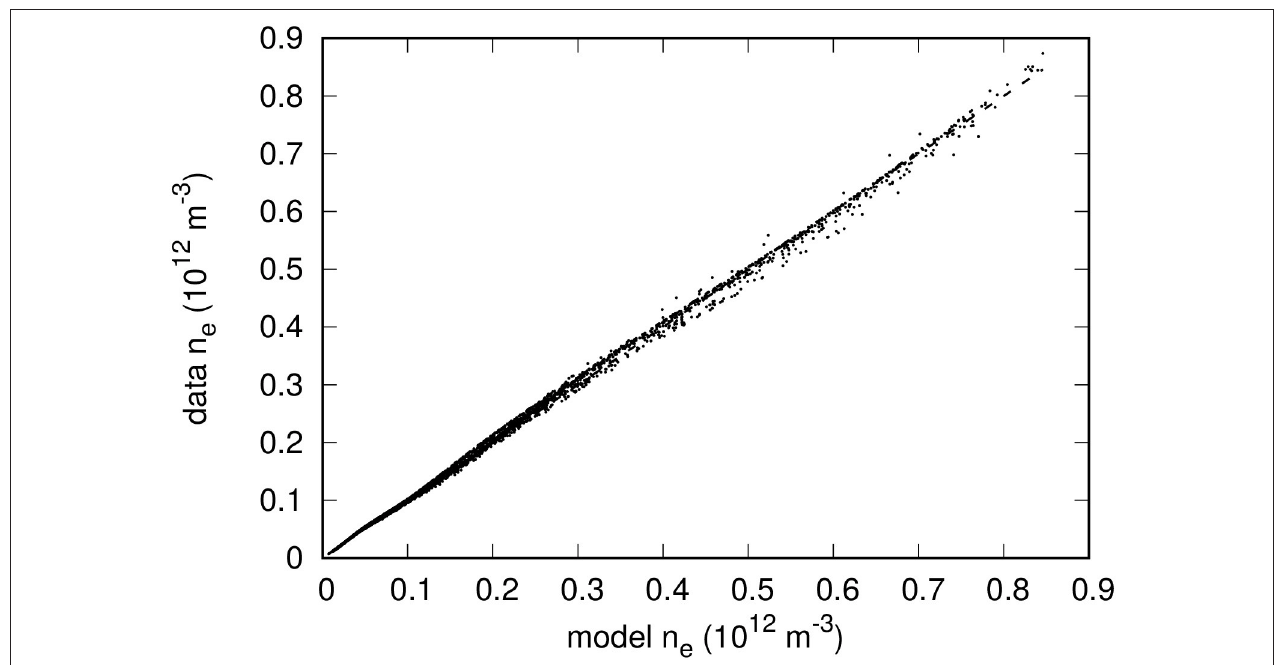
FIGURE 8 | Comparison between model-predicted and actual densities from the validation data set. The neural network used here was trained with 100 randomly selected characteristics. The dashed line corresponds to a perfect correlation between the two densities.